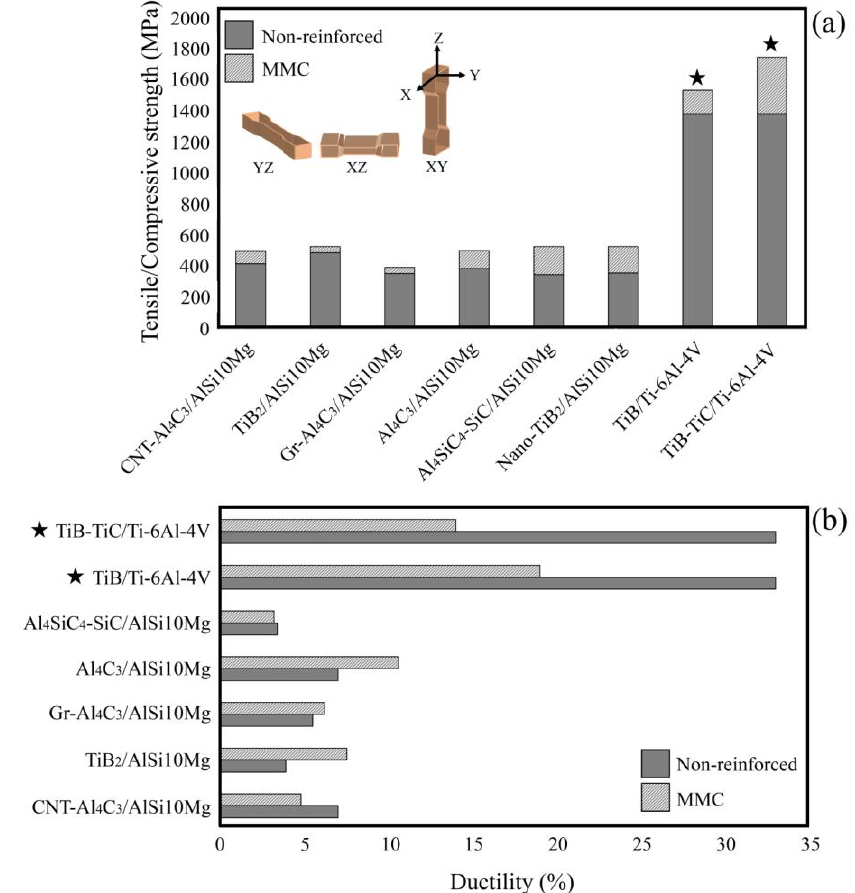
Figure 13. A comparison between ( a ) the tensile strength and compressive strength (*), and ( b ) the ductility of the SLM-fabricated AMCs/TMCs and their monolithic alloys in CNT-Al 4 C 3 /AlSi10Mg [70], TiB 2 /AlSi10Mg [72], Gr-Al 4 C 3 /AlSi10Mg [73], Al 4 C 3 /AlSi10Mg [68], Al 4 SiC 4 -SiC/AlSi10Mg [74], Nano-TiB 2 /AlSi10Mg [56], TiB/Ti-6Al-4V [79] and TiB-TiC/Ti-6Al-4V [79] systems. The orientation of samples is as YZ in [70], XZ in [73], and XY in [79] and [72], as schematically shown in ( a ). Note: samples do not have the same dimensions.